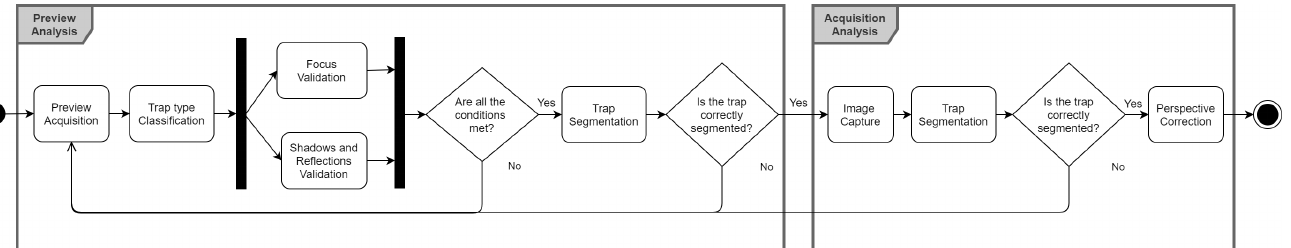
Figure 1. Application flow for image quality and adequacy